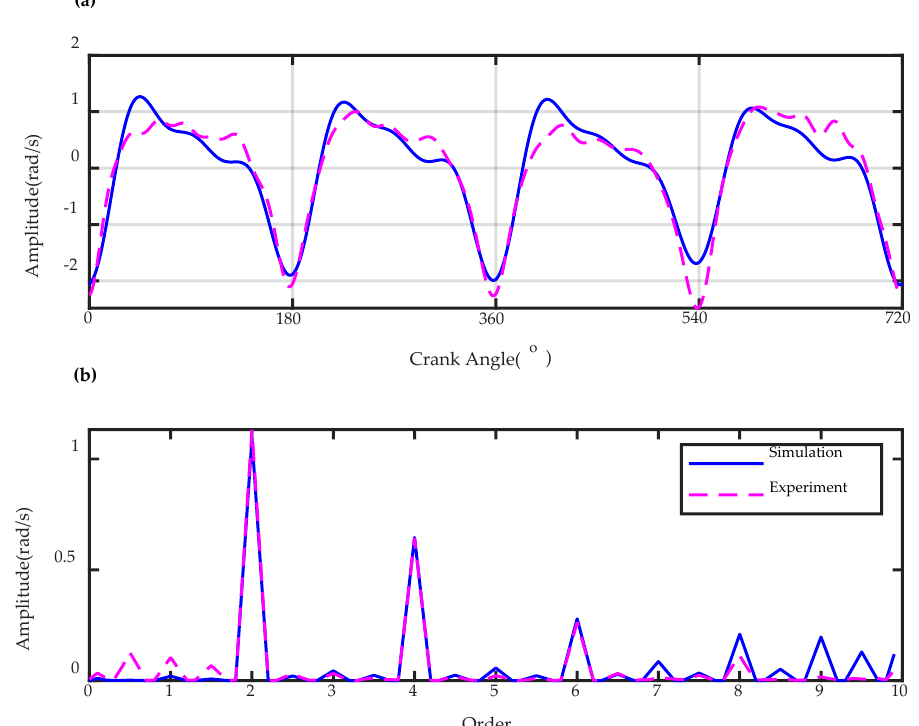
Figure 9. Simulated and experimental IAS values of the flywheel: ( a ) in the angular domain; ( b ) in the frequency domain.